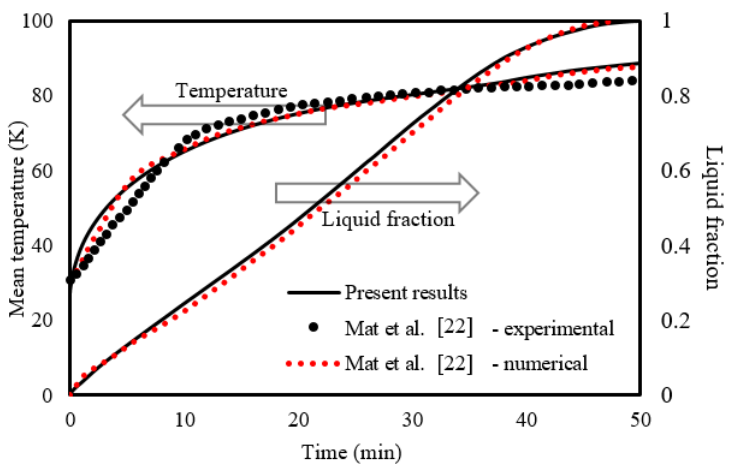
Figure 5. Verification of the numerical model.